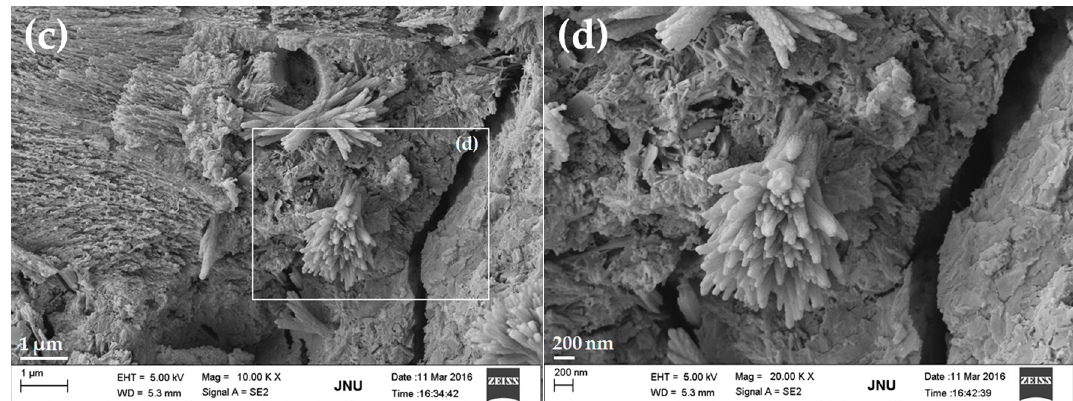
Figure 8. SEM images of fibrous-like and flower-like crystals in the cement paste with 0.25% bwoc GONSs: ( a ) a cluster of fibrous crystals found in the pore; ( b ) the local amplification for the area with the white box marked in image ( a ); ( c ) some flower-like crystals observed on the surface; and ( d ) the local amplification for the area with white box marked in the image ( c ).